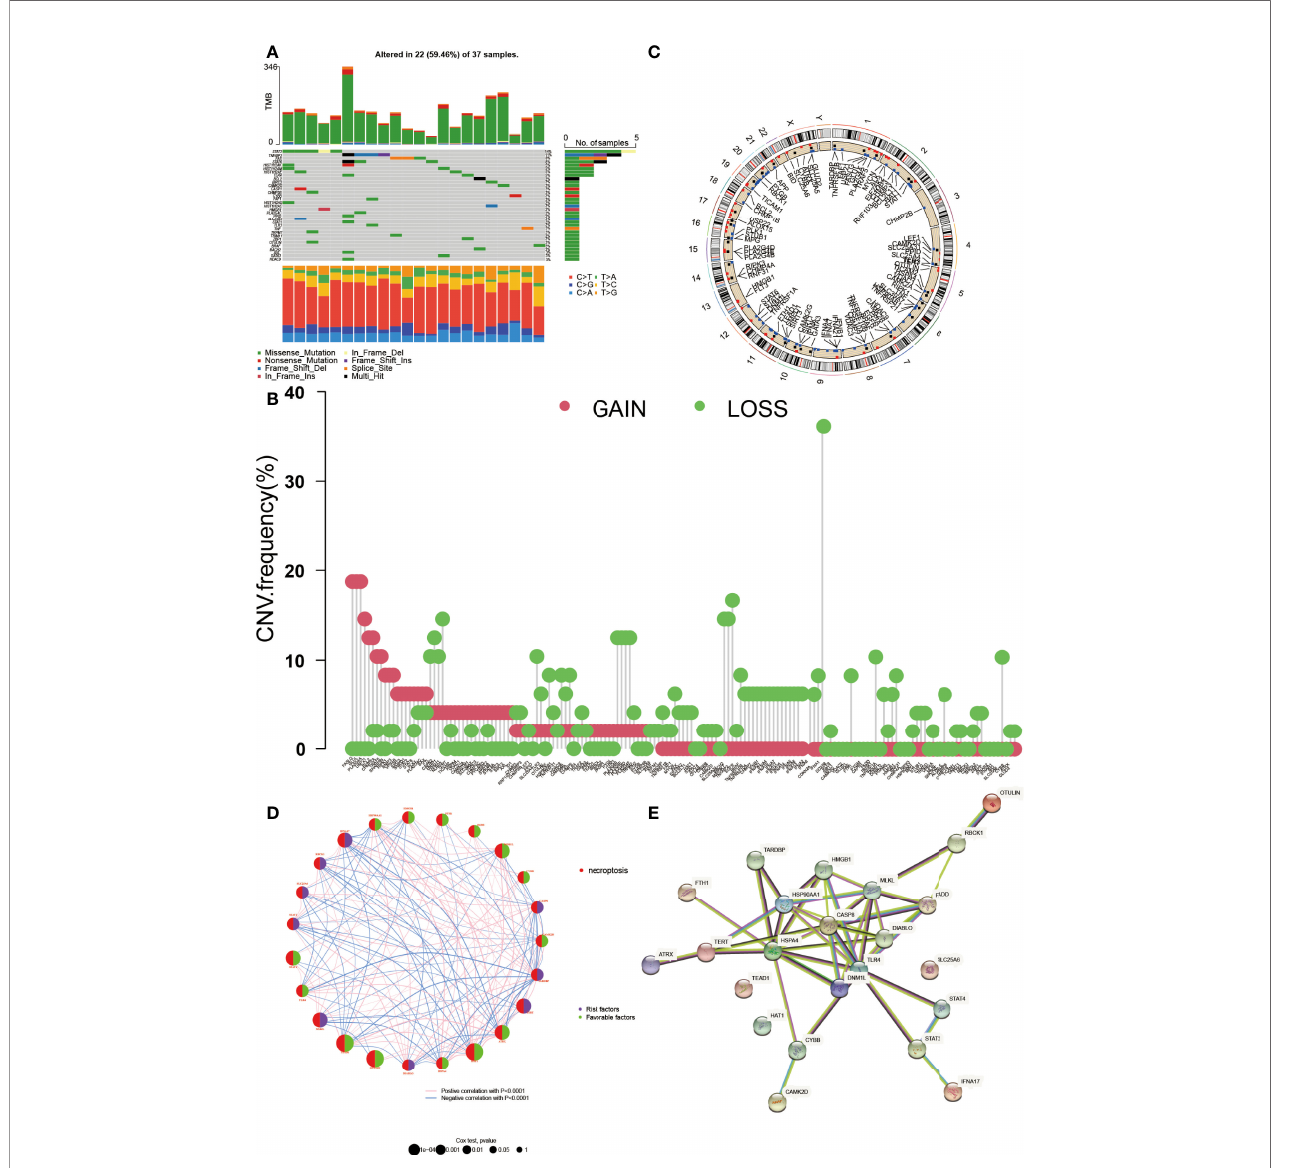
FIGURE 1 | The genetic landscape of NRGs in DLBCL. (A) The tumor mutation burden frequency and classi fi cation of NRGs in DLBCL. (B) The copy number variation (CNV) frequency of NRGs in DLBCL. The height represents the alteration frequency. (C) The location of the CNV alteration on chromosomes. (D) The gene interaction network of NRGs in DLBCL. The circle size indicates its signi fi cance. The right part of the circle represents its role, purple for risk factor and green for favorable. The line between genes means they were correlated with each other ( p < 0.0001). (E) The protein – protein interaction encoded by NRGs in DLBCL by